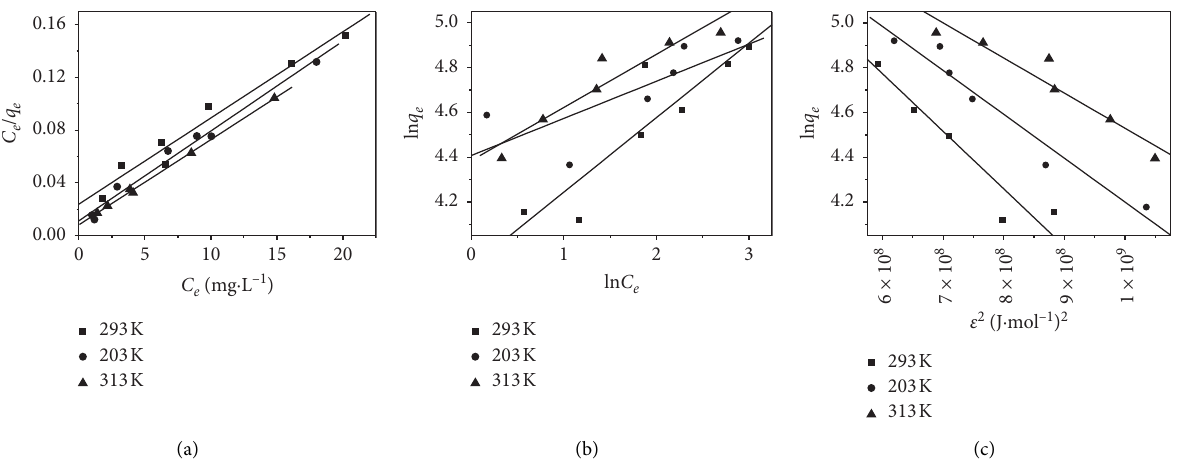
Figure 12: (a) Plots of Langmuir, (b) Freundlich, and (c) Dubinin – Radushkevich isotherms in linear form for the adsorption of phenol red onto CB at different